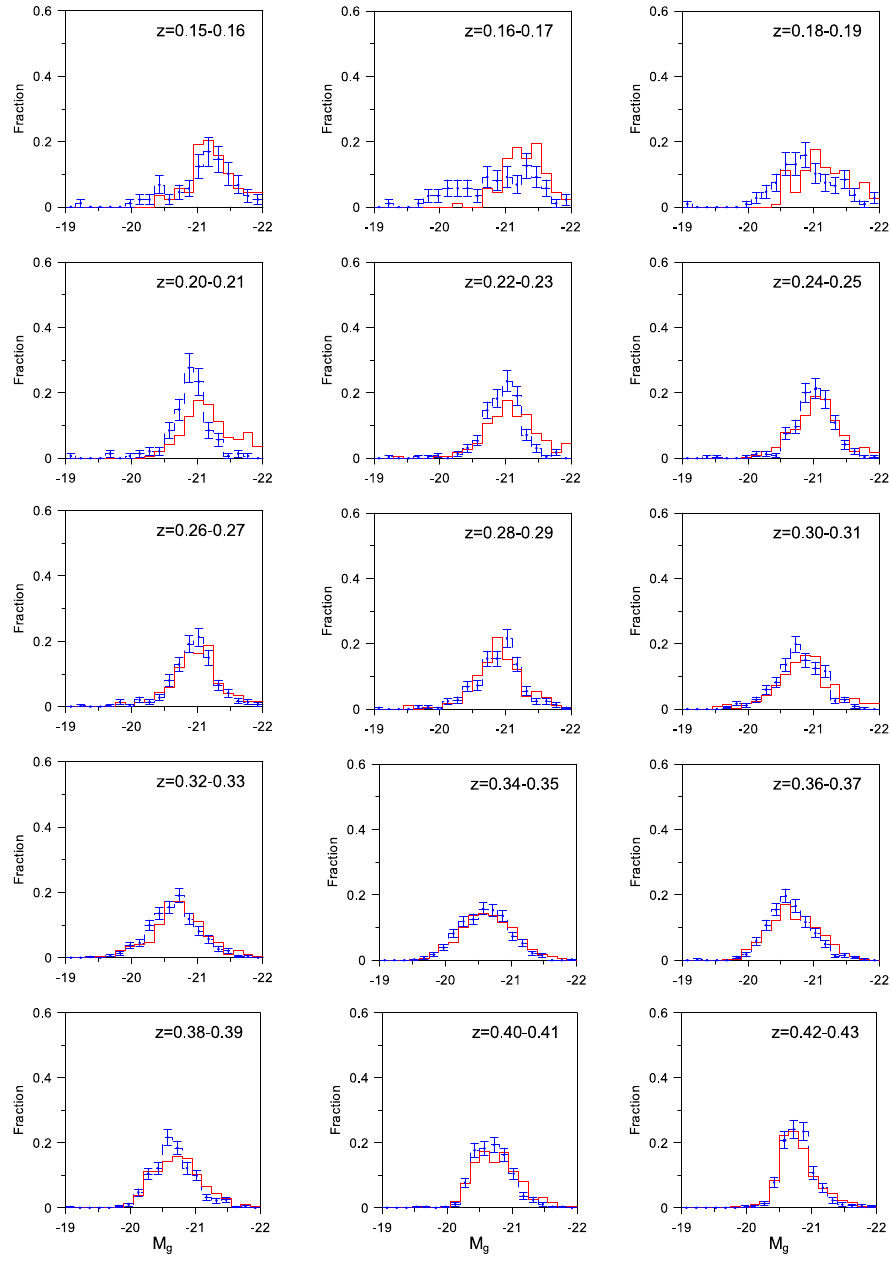
Fig. 2. Same as Fig. 1, but for the g -band absolute magnitude distribution at both density extremes in different redshift